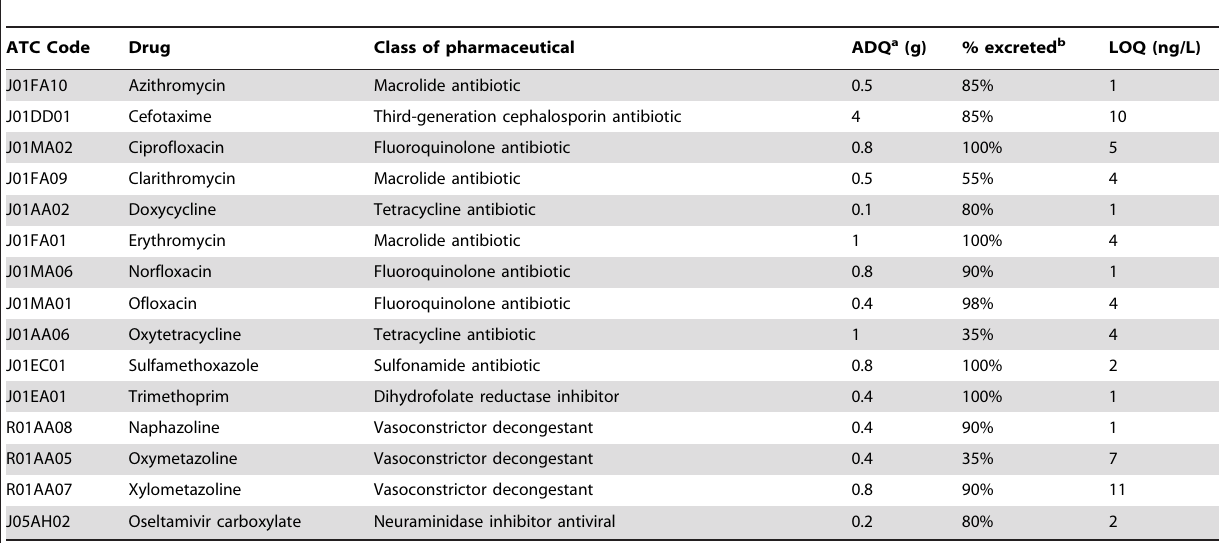
Table 1. Drug dosage, pharmacokinetics and limit of quantification (LOQ) of study analytes.